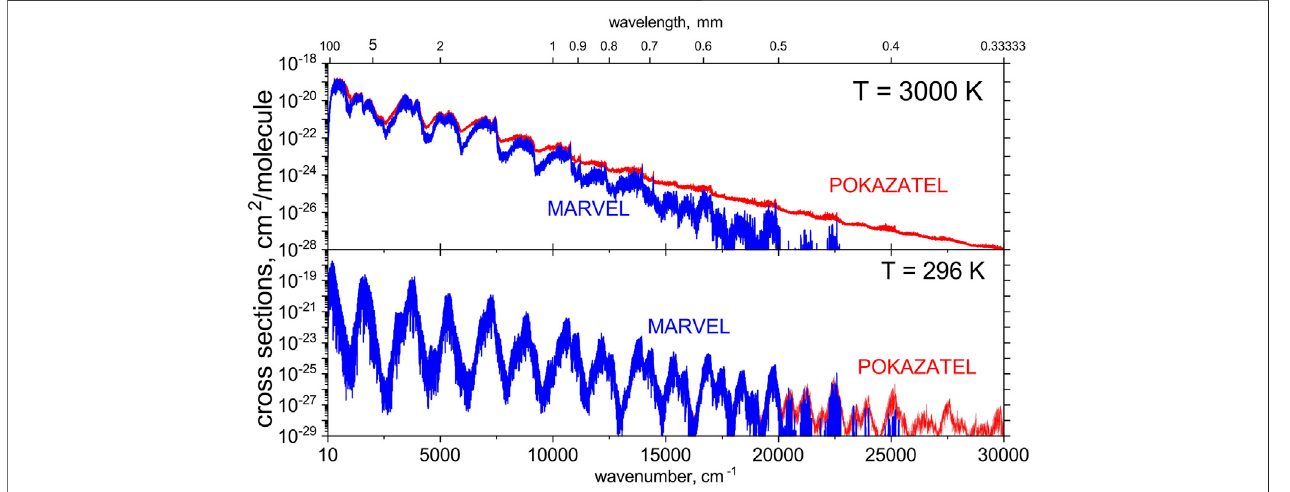
FIGURE 2 | Contribution of MARVEL states to the spectra of H 16 2 O (MARVEL) compared to the full spectra (POKAZATEL) for two temperatures, T (cid:1) 296 and 3000 K. In both cases the intensities are from the POKAZATEL line list (Polyansky et al., 2018). Note that the MARVEL curve represents only that part of the overall intensity given by transitions between energy levels determined using the MARVEL procedure. Here a Gaussian line pro fi le of half-width-half-maximum (HWHM) of 1 cm − 1 was used.